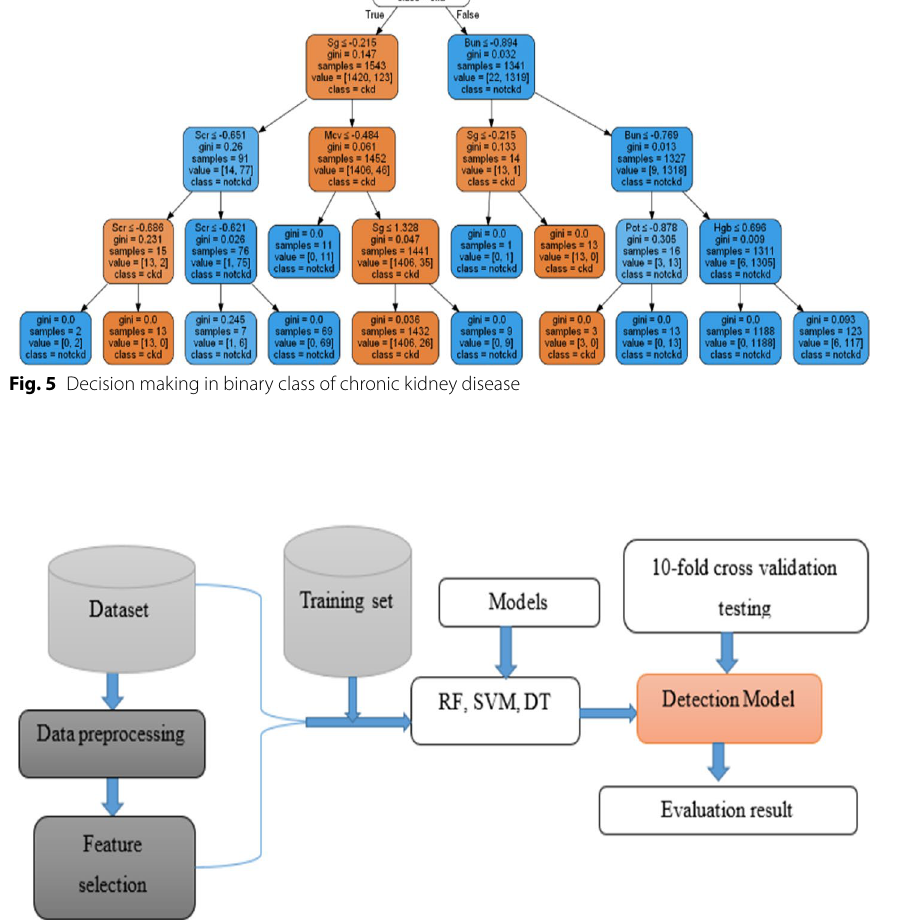
Fig. 6 Model building flow